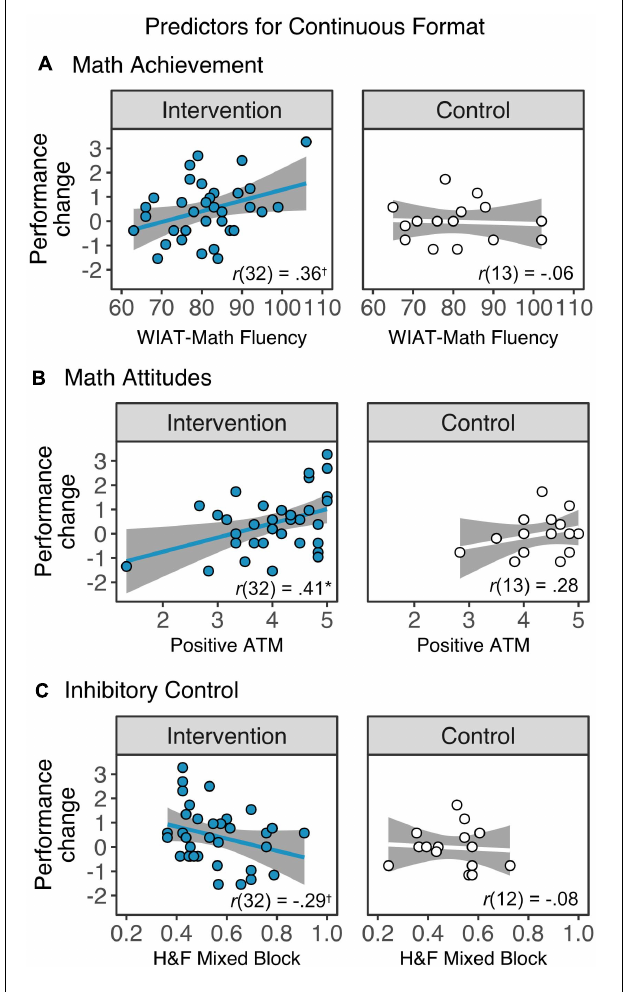
FIGURE 7 | Associations between changes in performance in discrete adjacent misleading trials of the Spinners task and (A) math achievement, as measured by the fluency subtests from the Wechsler Individual Achievement Test (WIAT)-III, (B) attitudes toward math (ATM), and (C) inhibitory control, as measured by the Hearts and Flowers (H&F) task. There were no significant correlations between individual difference measures and changes in the discrete adjacent misleading trials, except for a negative association between the initial inhibitory control of the intervention group and learning gains. * p corr <